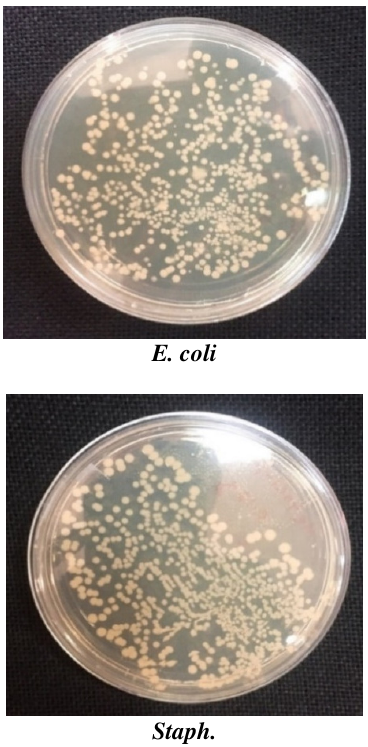
Fig. 2. Antibacterial activity of expired drug against E. coli and Staph. by the well diffusion method.